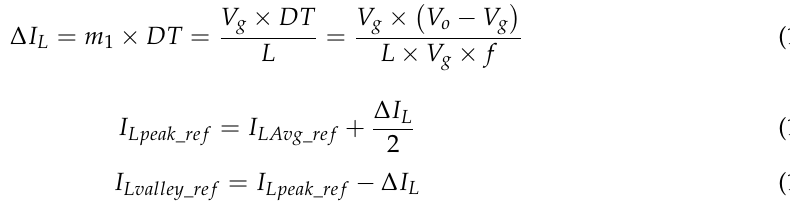
Figure 15. Inductor current due to changing output voltage.